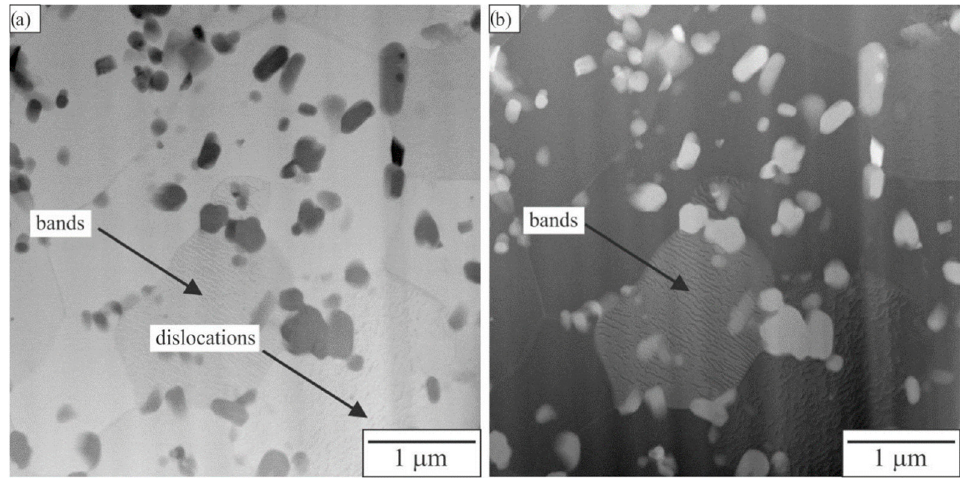
Figure 14. Microstructure in the TMAZ of sample FSP950. ( a ) Bright-field and ( b ) HAADF STEM micrographs.